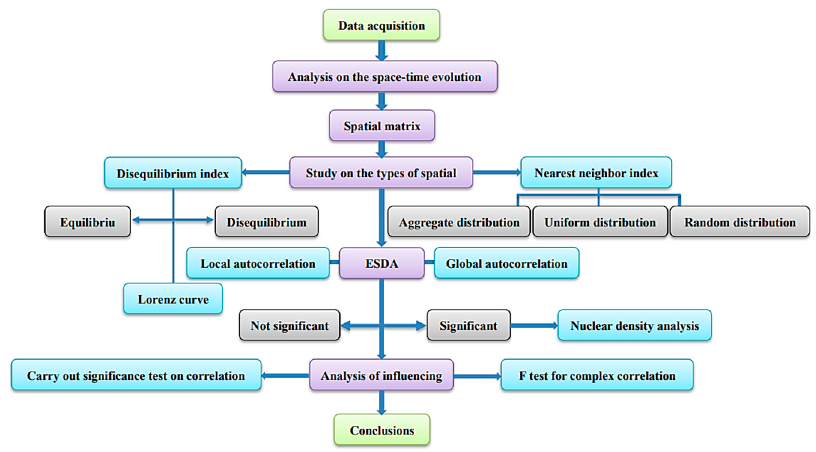
Figure 2. The framework diagram of research methods using spatial econometric model in this paper.